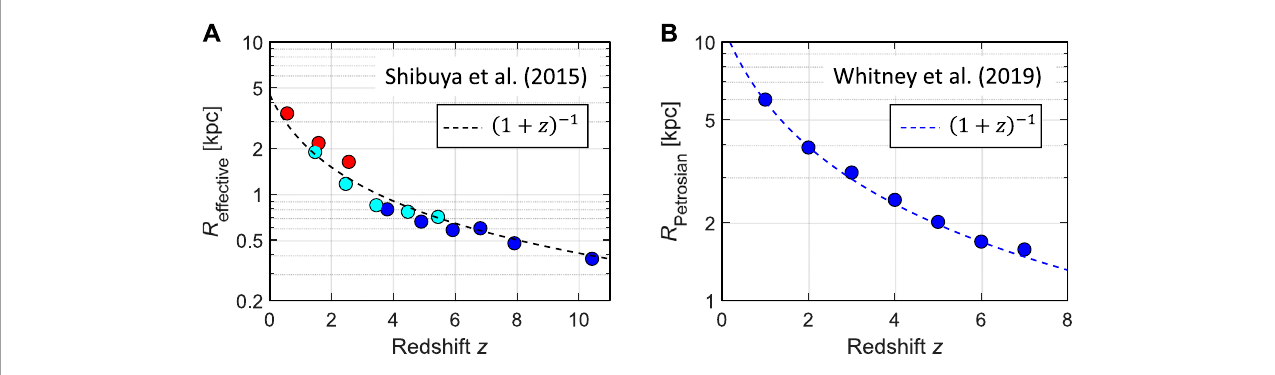
FIGURE 8 Galaxy size evolution with redshift. (A) Median of the effective galaxy radius R as a function of redshift for galaxies in the bin of L UV = ( 0 . 3 − 1 ) L * and cyan filled circles indicate radius R for star-forming galaxies measured in the optical (4 , 500 – 8 , 000 Å) and UV (1 , 500 – 3 , 000 Å) wavelength ranges, respectively. The blue filled circles indicate radius R for the Lyman break galaxies measured in the UV wavelength range. For details, see Shibuya et al. (2015, their Figure 8). (B) Median Petrosian radius of galaxies as a function of redshift for the mass-limited sample in the range of 10 9 M ⊙ ≤ M * ≤ 10 10.5 M ⊙ . The ratio of the surface brightness at radius R to the mean surface brightness of a galaxy is η = 0 . 2. For details, see Whitney et al. (2019, their Figure 8). The dashed lines in (A, B) show the size evolution predicted by the presented theory.